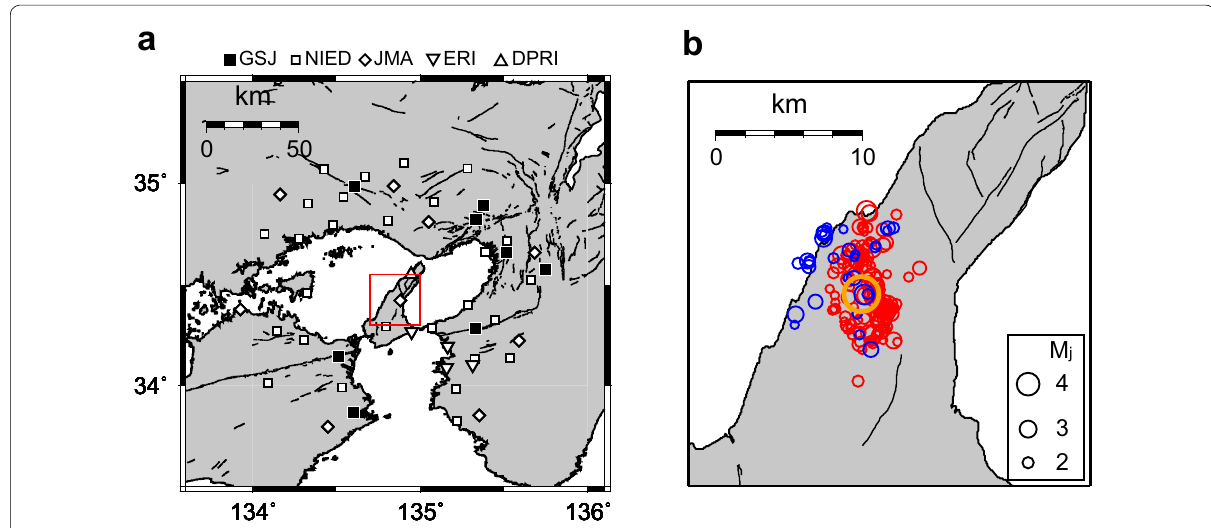
Fig. 3 Seismic stations and earthquakes analyzed in this study. a Distribution of seismic stations used for the hypocenter and focal mechanism determination. b Earthquake locations analyzed in this study. Pre-shocks, the mainshock, and aftershocks are shown by blue, orange, and red circles. The map area corresponds to the red rectangle in a